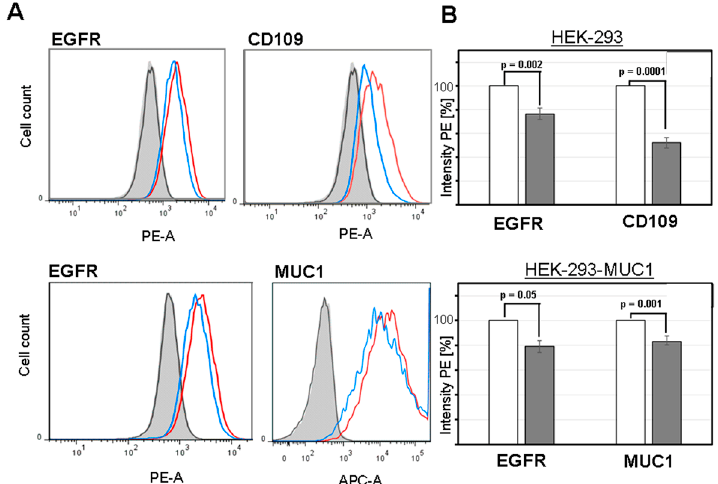
Figure 5. Plasma membrane marker glycoproteins EGFR, CD109, and MUC1 show a decrease of surface expression in fluorescence-activated cell sorting (FACS) induced by F-Gal. ( A ) Cell separation by triplicate FACS analyses revealed changes of membrane marker expression in HEK293 and HEK293-MUC1 cells in the absence (red) or presence of F-Gal (blue). Cells were cultured in low-Glc / low-Gal medium. ( B ) The bar diagram shows relative fluorescence intensities (%) for HEK293 or HEK293-MUC1 cells grown in the absence (white) or presence of F-Gal (dark grey). Cells were cultured in low-Glc/low-Gal medium.